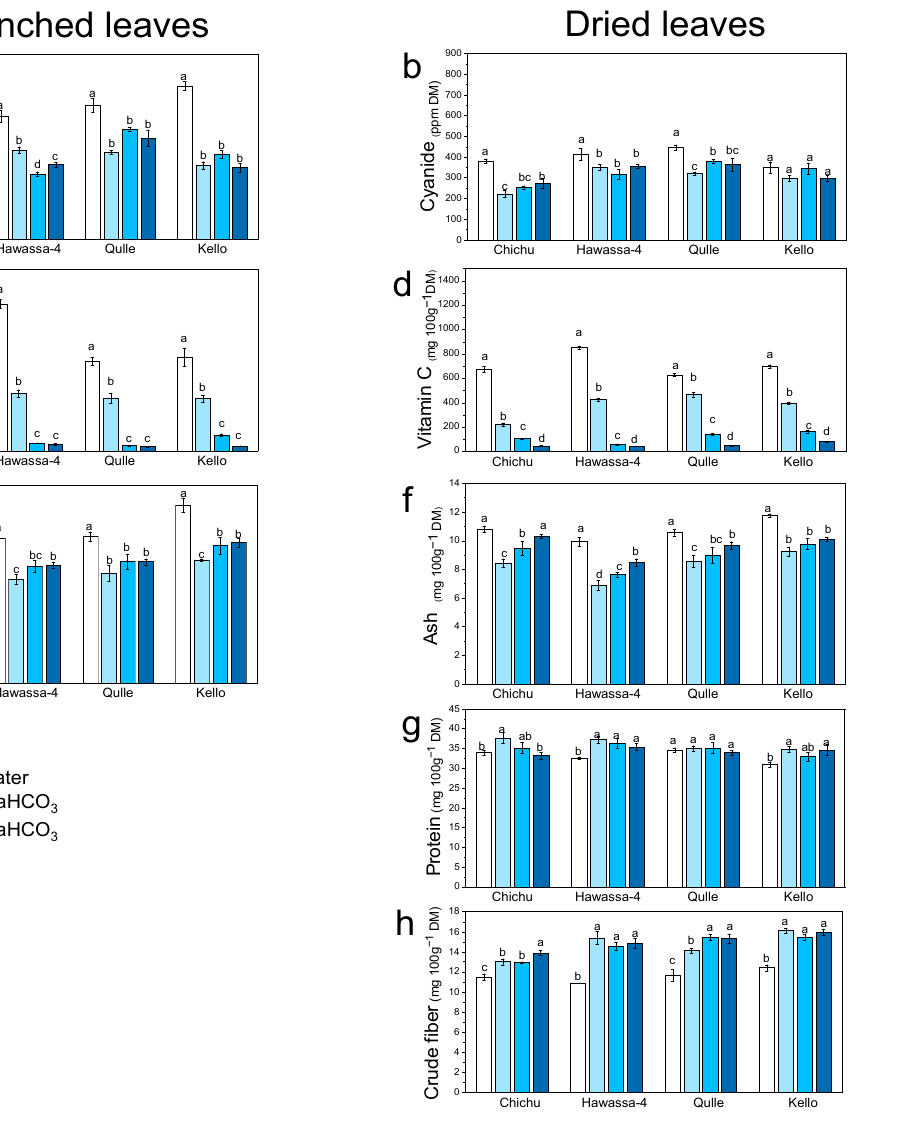
Figure 1 . Influence of blanching and drying on ( a , b ) cyanide, ( c , d ) vitamin C, ( e , f ) ash, ( g ) protein, and ( h ) crude fiber content of leaves from Ethiopian cassava varieties. Bars with the same letter are not significantly different from other samples within the same variety.